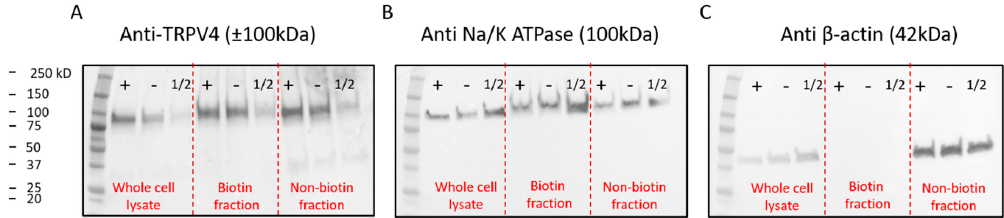
Figure A3. Effect of ZC4H2 on TRPV4 function is not stimulus specific. Representative time course traces of the intracellular Ca 2+ concentration ([Ca 2+ ] i ) (mean ± SEM) in non-transfected (NT) HEK-293T cells ( n = 30), and cells co-transfected with TRPV4 and mCherry or TRPV4 and ZC4H2-mCherry, upon stimulation with ( A ) HTS and ( B ) 4 α PDD (10µM).